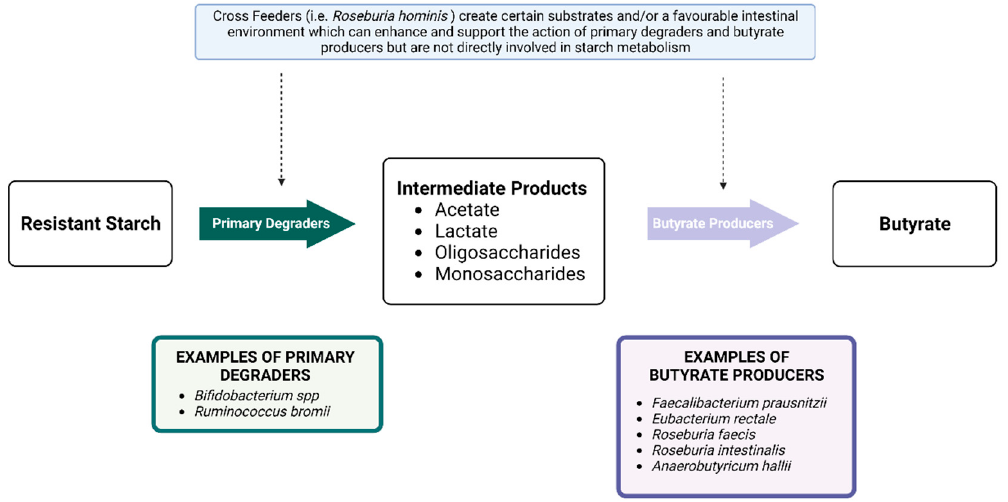
Figure 5. An overview of bacteria associated with resistant starch and the production of butyrate. Created with Biorender.com.